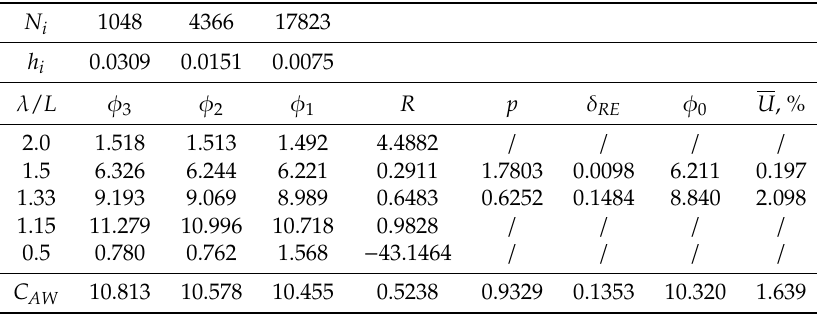
Table 3. Convergence study for panel size used to discretize KCS.